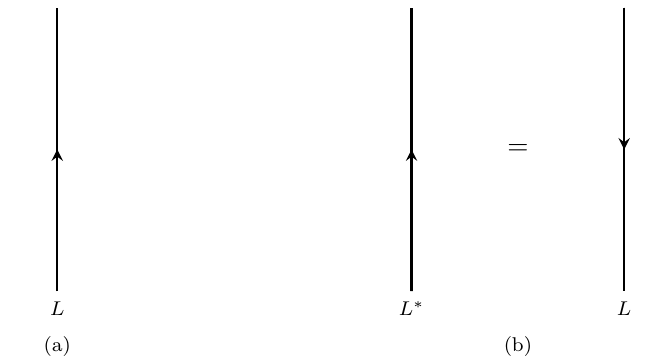
Figure 1 . (a) A boundary line L . (b) The dual line L (cid:3) is de(cid:12)ned by reversing the orientation of L .